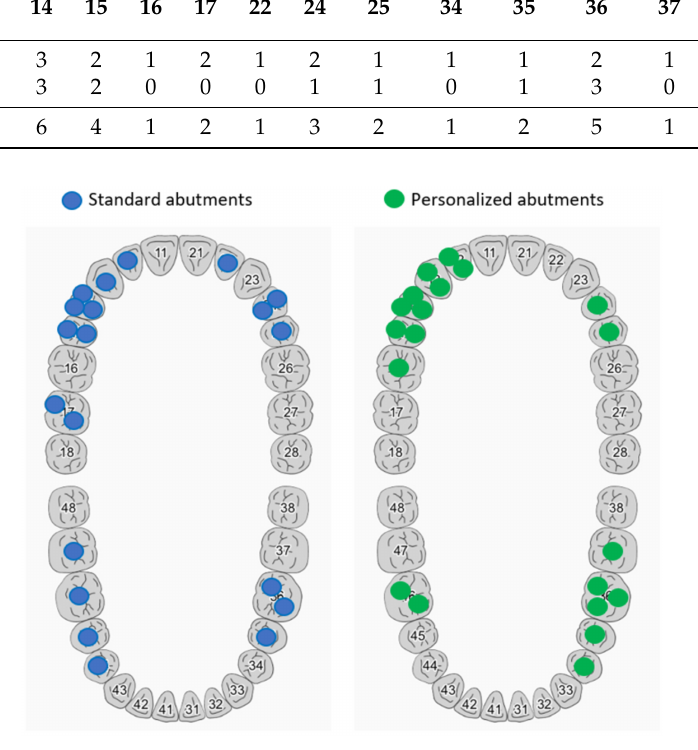
Figure 6. Abutments’ distribution on